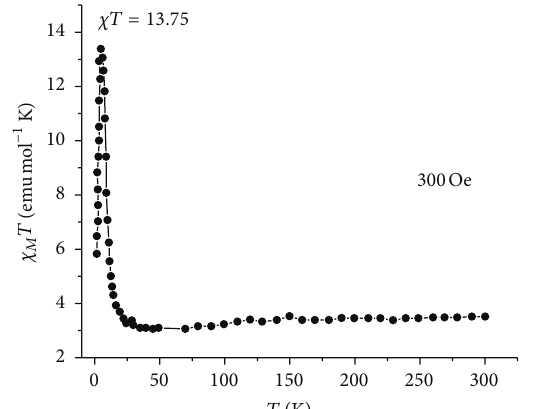
Figure 12: Temperature dependence of 𝜒 𝑀 𝑇 versus 𝑇 for